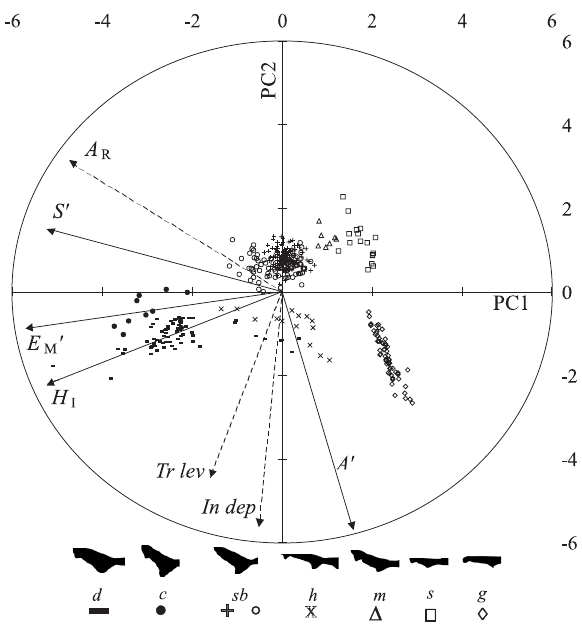
Fig . 7. – Pca-biplot representing cases ( G. melastomus : g , open dia- monds, S. canicula : s , open squares, M. asterias : m , open triangles, C. uyato : c , filled circles, D. licha : d , horizontal bars, S. blainvillei : sb ; females: open circles, males: plus and H. perlo : h , crosses) active ( S’ : body size-standardised caudal span, A’ : body size-standardised ’ : muscular-skeletal amount per unit length and H caudal area, E : m i hepatosomatic index) and supplementary ( A caudal fin aspect ratio, r Tr lev trophic level and In dep depth inhabited) variables projected on the principal component-plane (Pc1*Pc2). Solid and dashed vectors represent active and supplementary variable correlations respectively, with horizontal (Pc1) and vertical (Pc2) components from Pca. the schematic representation of the species’ caudal shapes is also